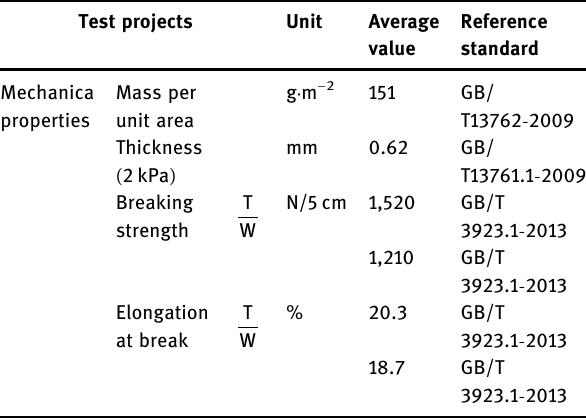
Table 4: Mechanical parameters of